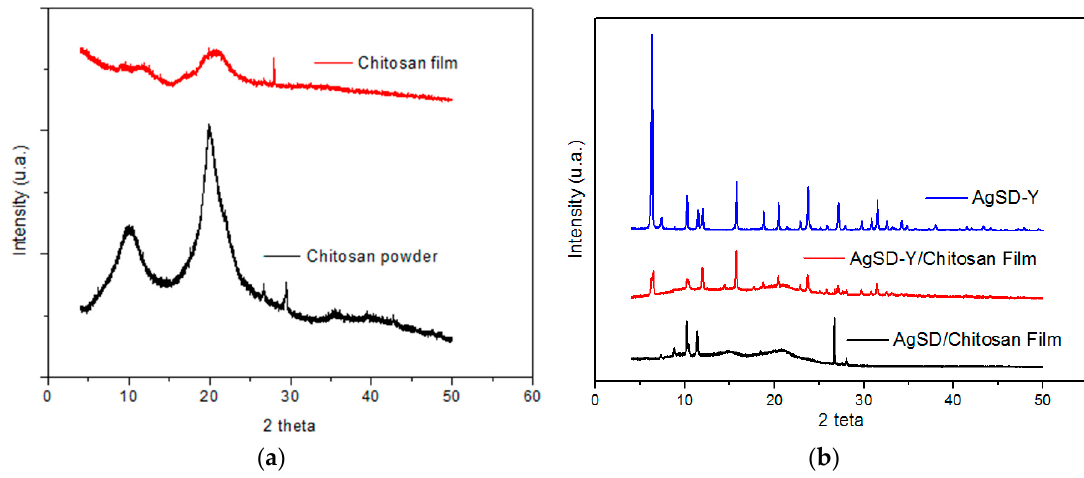
Figure 8. Diffractograms of ( a ) chitosan films, chitosan powder and ( b ) AgSD-Y powder, AgSD-Y/chitosan film and AgSD/chitosan film.